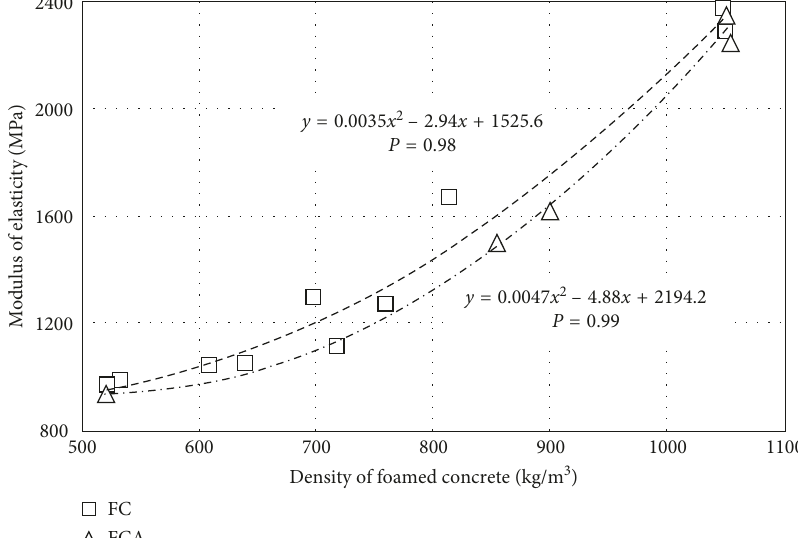
Figure 6: Modulus of elasticity of foamed concrete FC and FCA as a function of density of foamed